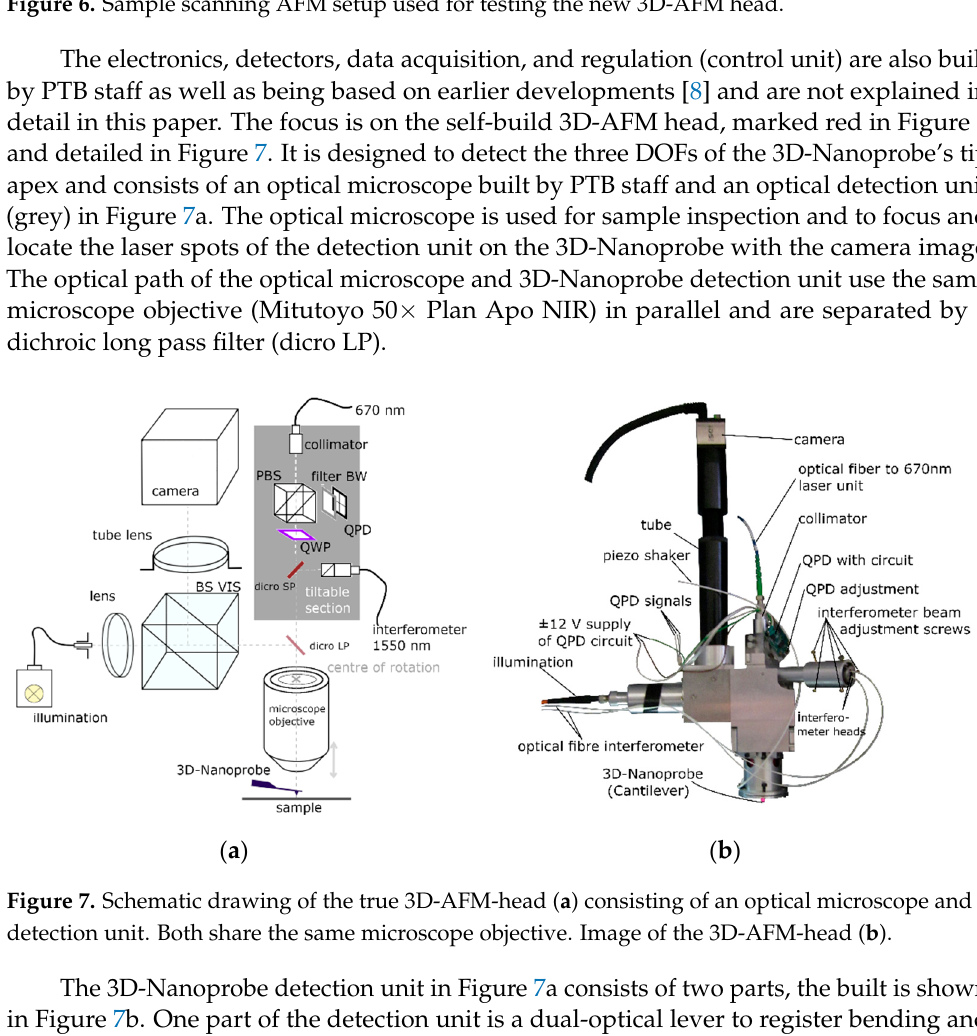
Figure 6. Sample scanning AFM setup used for testing the new 3D-AFM head.